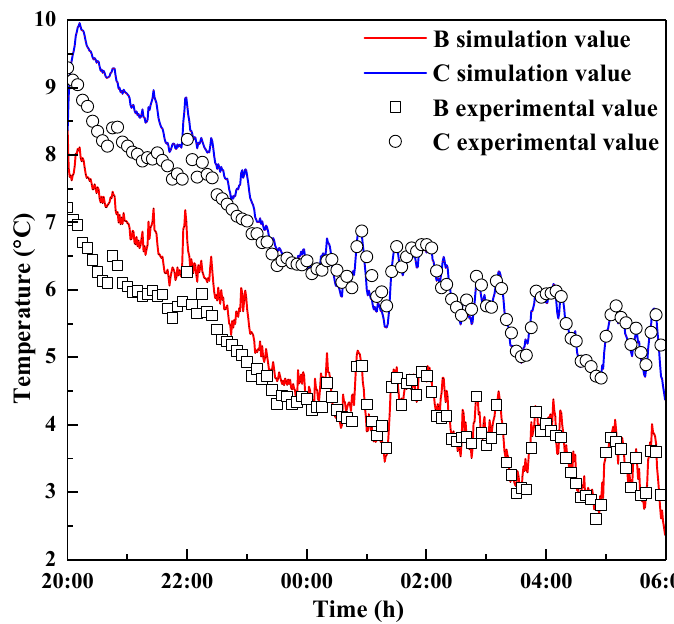
Figure 11. The comparison of experimental and simulated values of point B and C. Table 3. The root mean square error (RMSE) and mean absolute error (MAE) of points B and C. Parameter